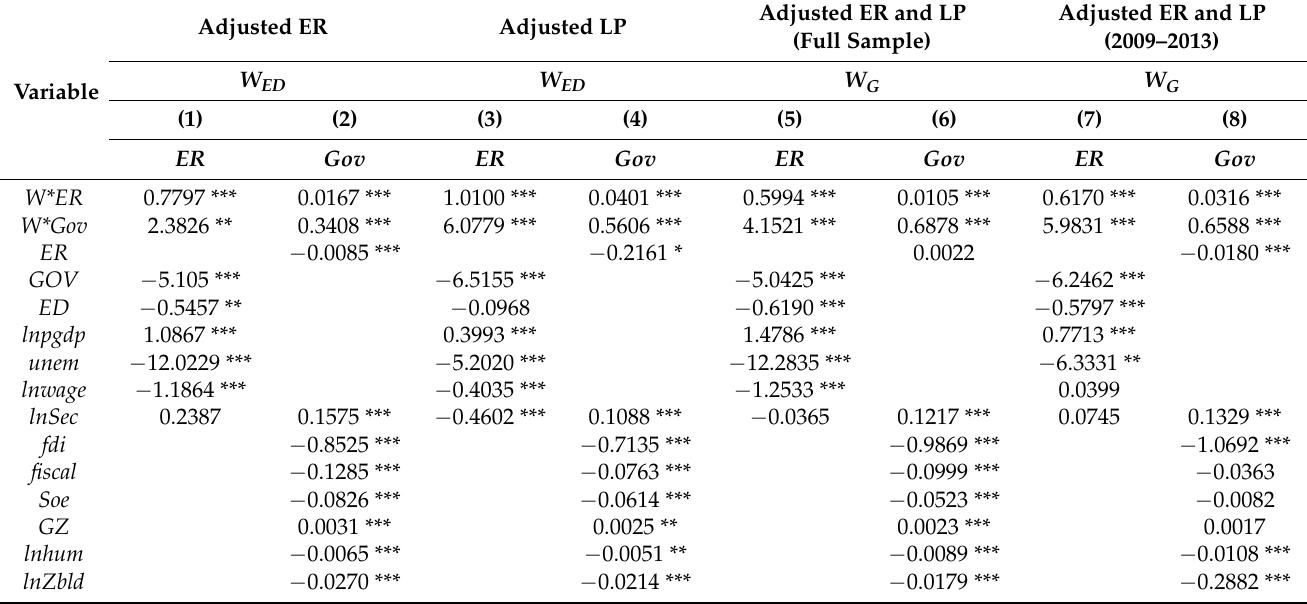
Table 5. Results of the robustness test of adjusted